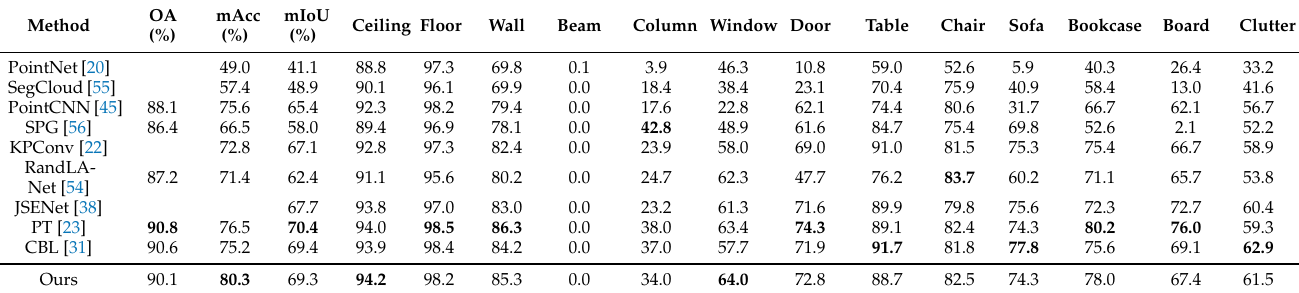
Table 3. Quantitative comparison on S3DIS Area 5 dataset. Results of the overall accuracy (OA), the mean accuracy (mAcc), and the mean IoU (mIoU) are listed. The bold denotes the best performance. Chair Sofa Bookcase Board